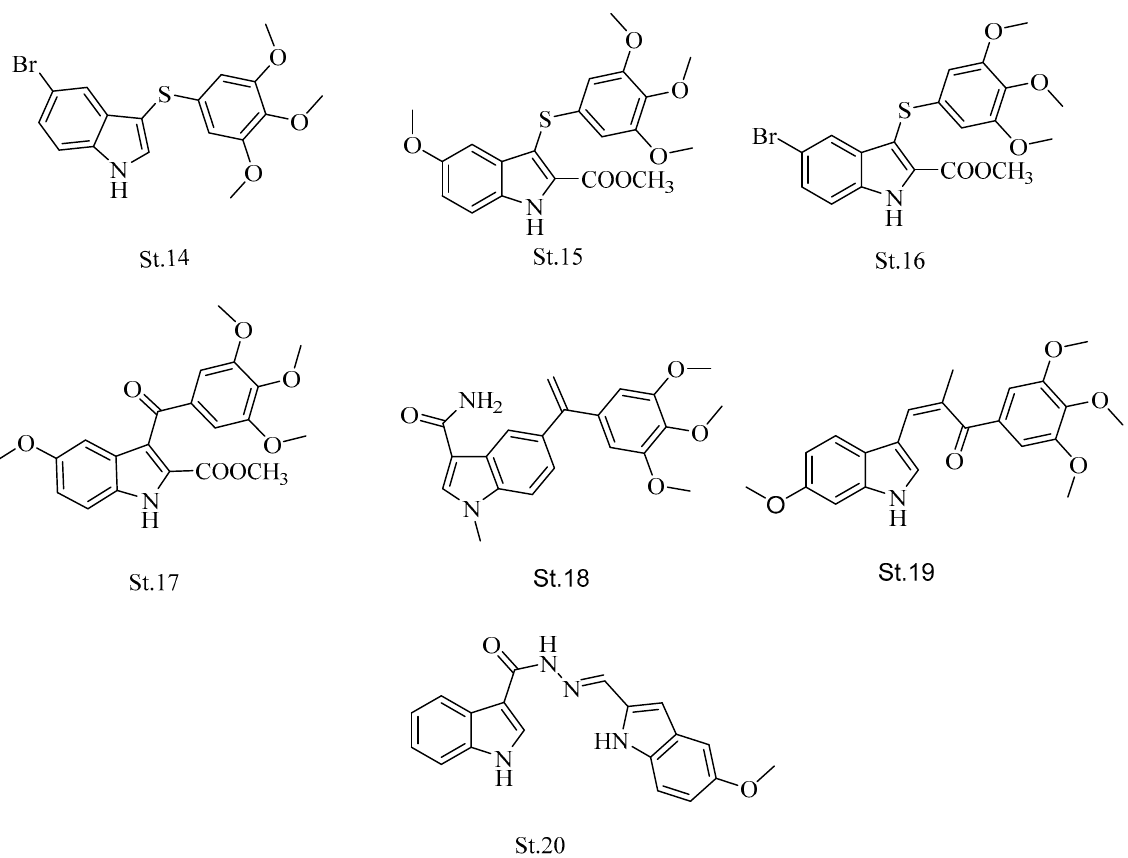
Figure 6. The structures of arylthioindole, trimethoxyphenyl-indole, and bis-indole.